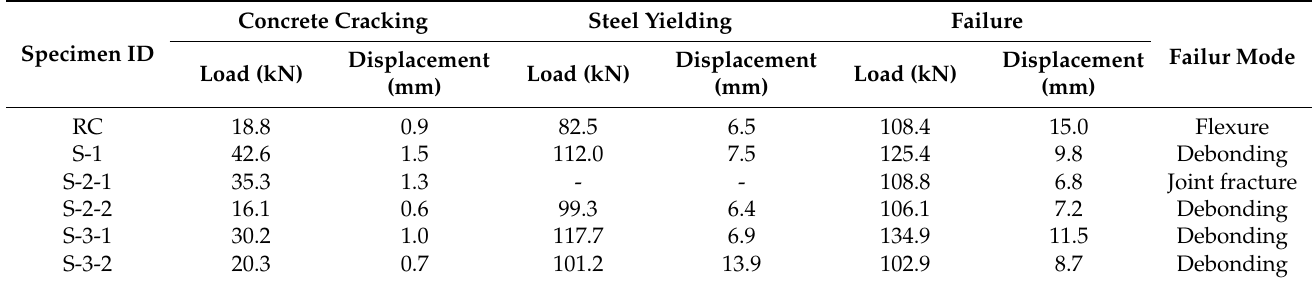
Table 7. Test results of failure test for strengthened slab